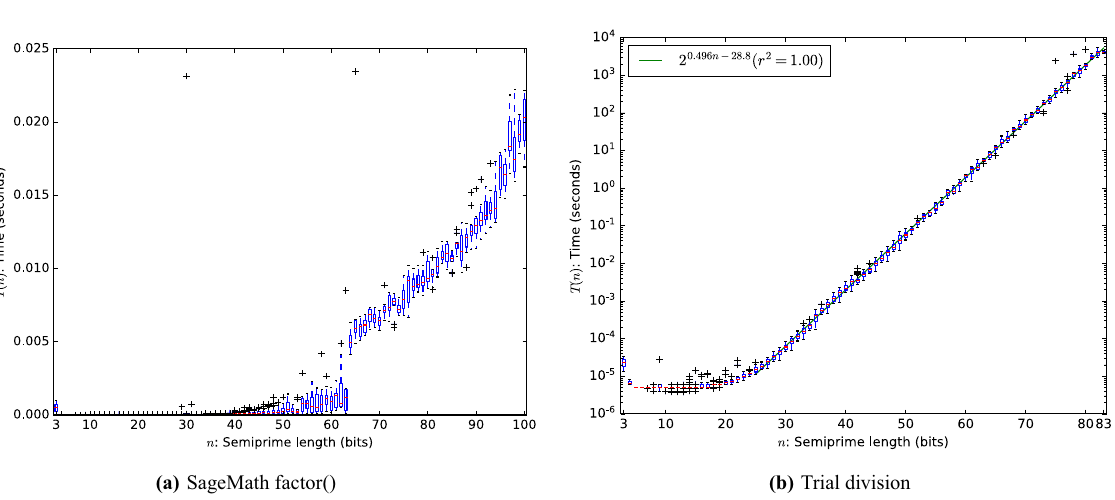
Figure 5. Runtime of factoring using numerical methods. No randomization was applied for obtaining these